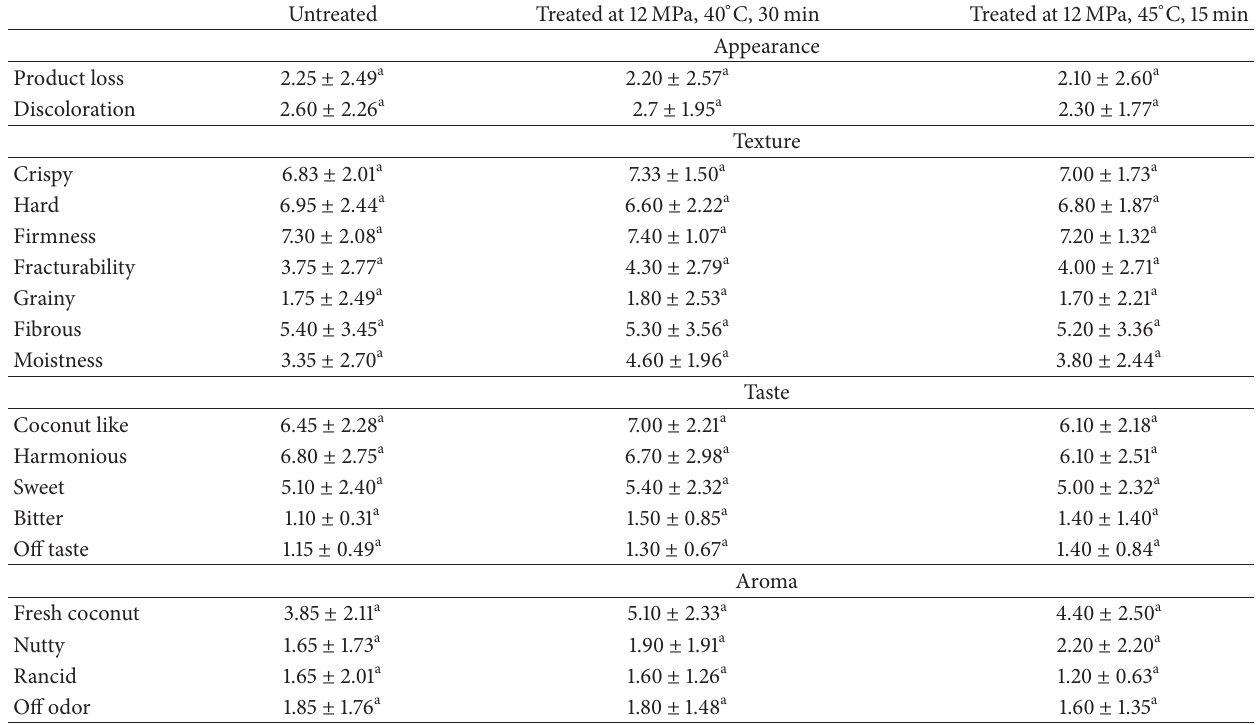
Table 4: Sensory evaluations of fresh-cut coconut before and after SC-CO